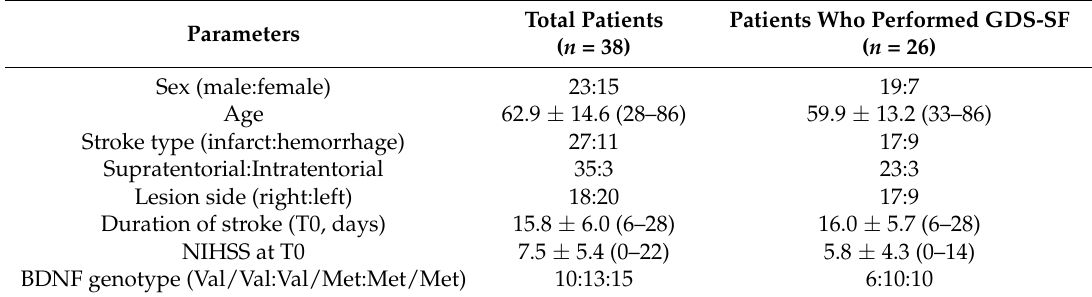
Table 1. General characteristics of